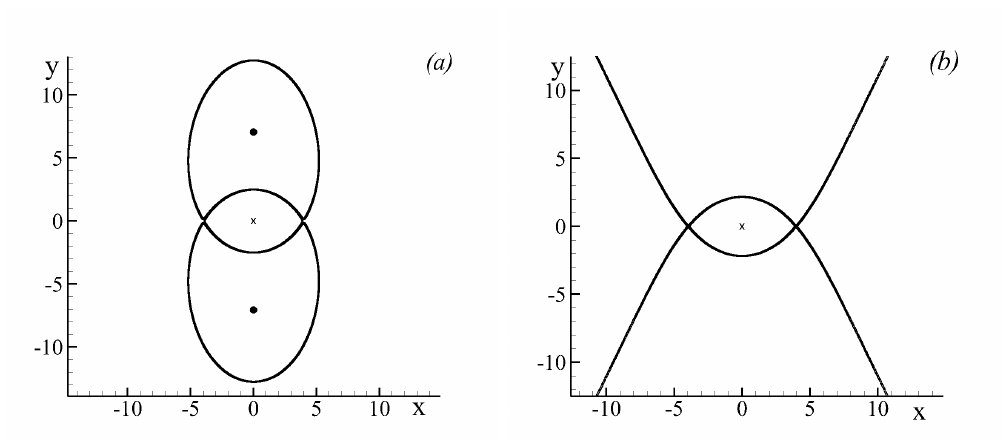
Figure 3. Typical phase portraits of the two-vortex problem in a steady deformation flow: ( a ) rotation dominates over strain, | S 0 | < | Ω 0 | ; and ( b ) strain dominates rotation, | S 0 | > | Ω 0 |